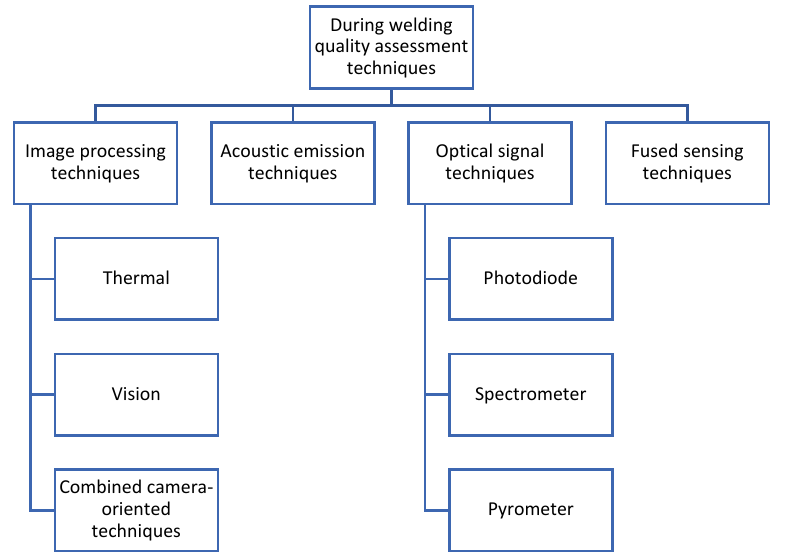
Figure 2. Quality assessment during welding [34].